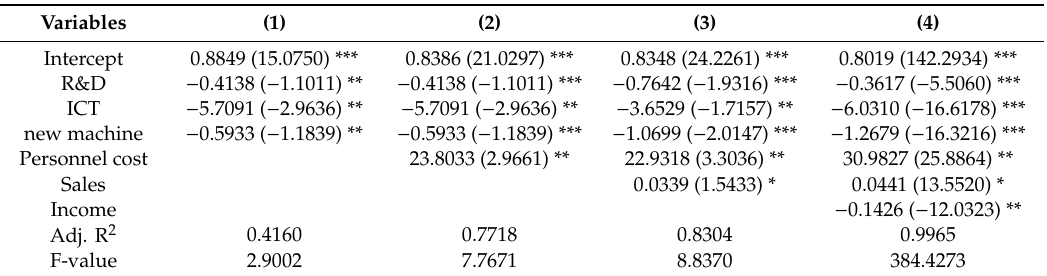
Table 3. Regression results. The dependent variable is the total debt provided / total liabilities (2011)